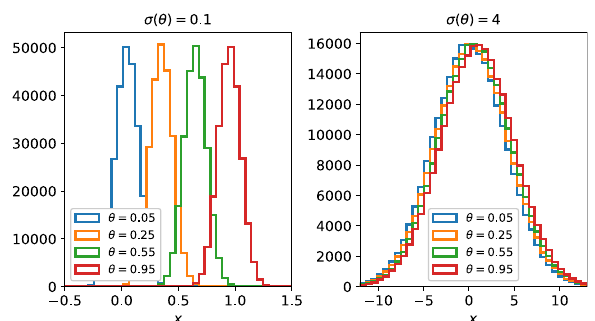
Fig. 2 Examplesoftemplates(trainingdatafordiscreteparameterval- ues) of an observable x for different values of a parameter θ . When the observabletemplatesaredistinguishable(left),theedgebias(seetext)is negligible. When the templates are harder to distinguish over the range of θ (right), the correction for the edge bias is critical